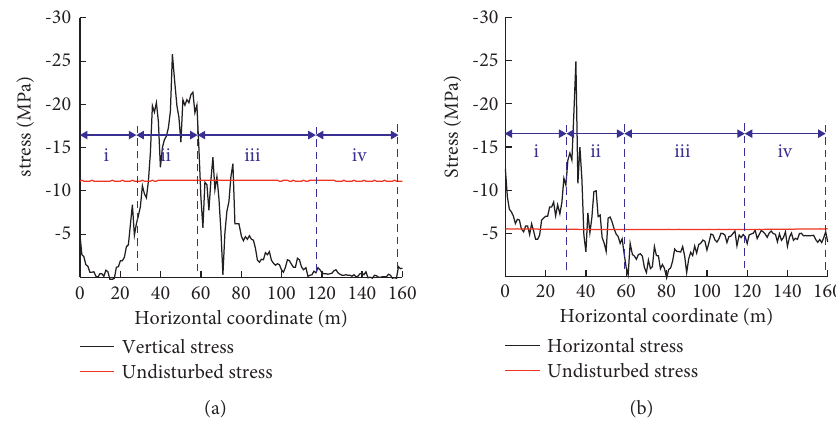
Figure 9: Final stress distribution in the longwall gob: (a) vertical stress and (b) horizontal stress and (i) voussoir influencing zone; (ii) compacted zone; (iii) compacting zone; and (iv) pilling zone.